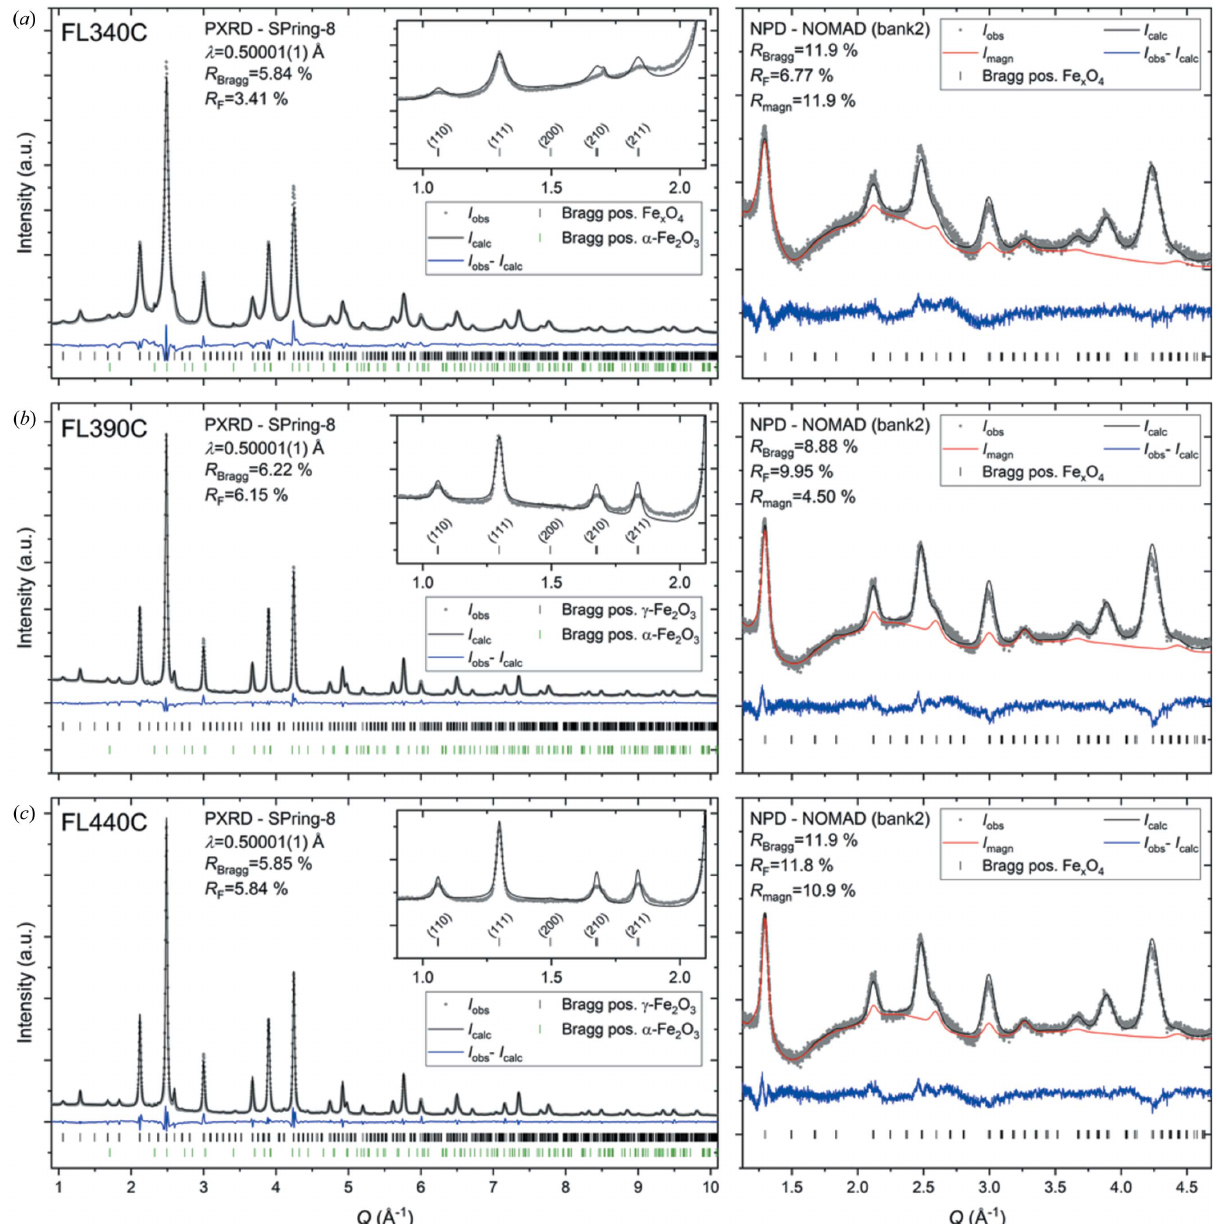
Figure 3 Joint refinements of SPring-8 high-resolution synchrotron PXRD data (left) and selected NOMAD time-of-flight NPD data (right) for the samples synthesized at ( a ) 340, ( b ) 390 and ( c ) 440 (cid:4) C. The additional NPD datasets from the other data banks and the corresponding fits may be found in the Supporting information. The insets show the low Q region of the PXRD data and illustrate the presence of the additional superstructure peaks arising from vacancy ordering in the structure. The main results obtained from the Rietveld analyses are summarized in Table 2 and further details about refined parameters may be found in the Supporting